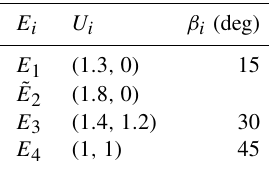
Figure 13. Function module and pole map. Table 2. Parameters of the